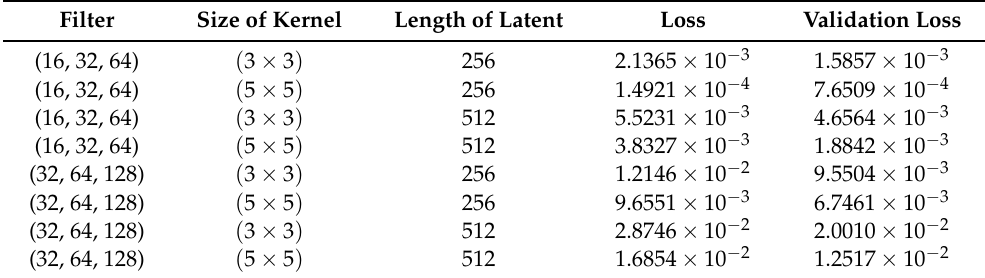
Table 3. Parameters of the Autoencoder.